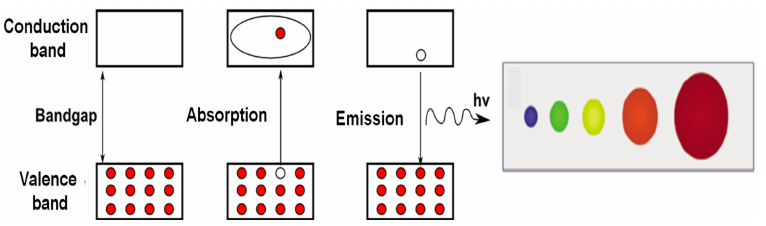
Figure 2. Representation of the confinement effect in QDs and the emission of photoluminescence. The color depends on the QD